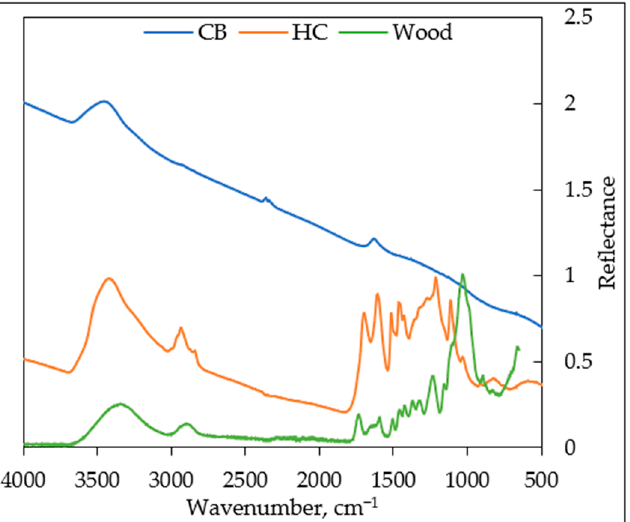
Figure 3. FTIR spectra of commercial carbon black (blue line), hydrochar (orange line), and sawdust (green line).